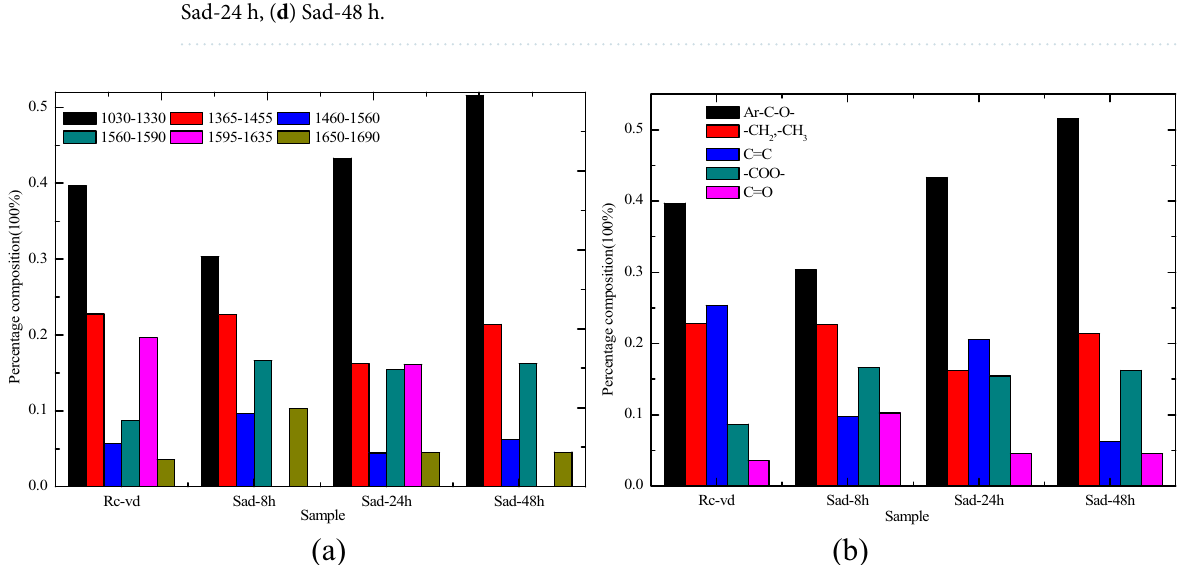
Figure 4. Content distribution of various functional groups for the 1000–1800 cm −1 band. ( a ) Percentages of different functional groups ( b ) percentage of different functional groups after the combination of two C=C